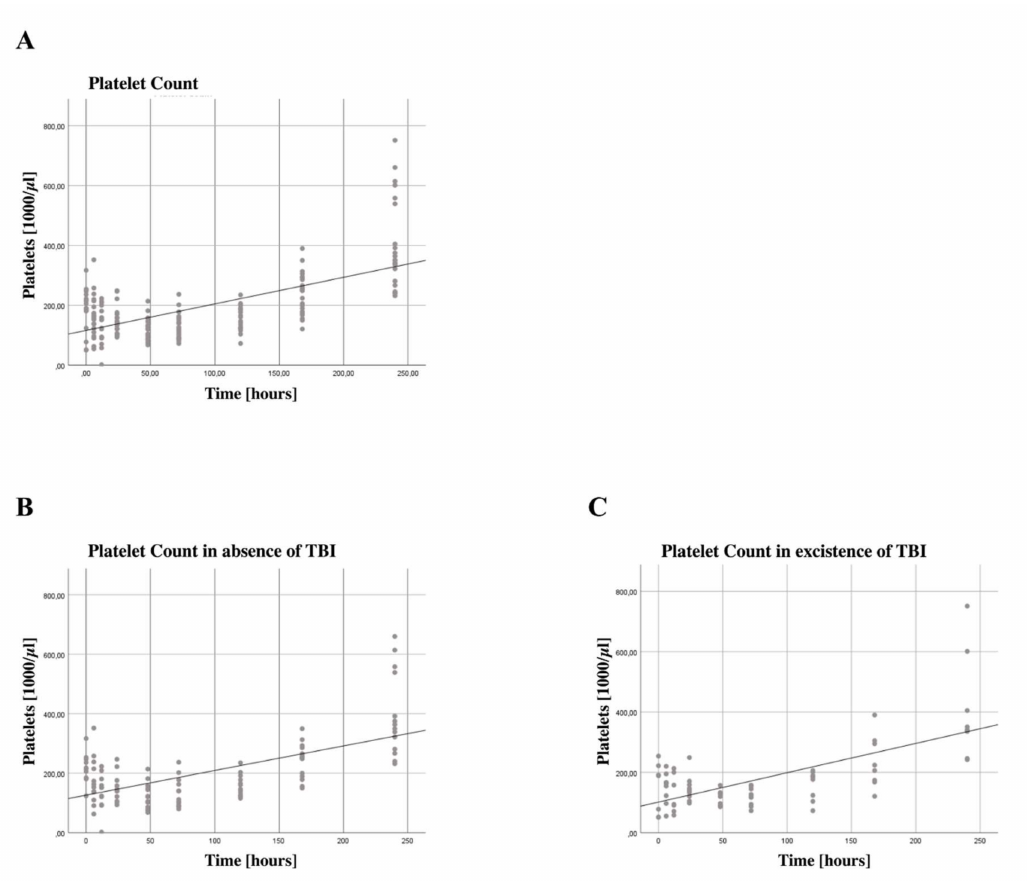
Figure 2. Absolute platelet count increased significantly over the first ten days after trauma. ( A ) The absolute platelet count was assessed in the emergency room (0), after 6, 12, 24 and 72 h, as well as after 5, 7 and 10 days. Generalized estimating equations (GEEs) were performed to test for statistically significant changes over time. We found a significant increase in platelet count (B = 23.190, SE = 3.3534, 95% CI [16.226, 30.155], p < 0.001), in the first 10 days after trauma for all patients. Patients